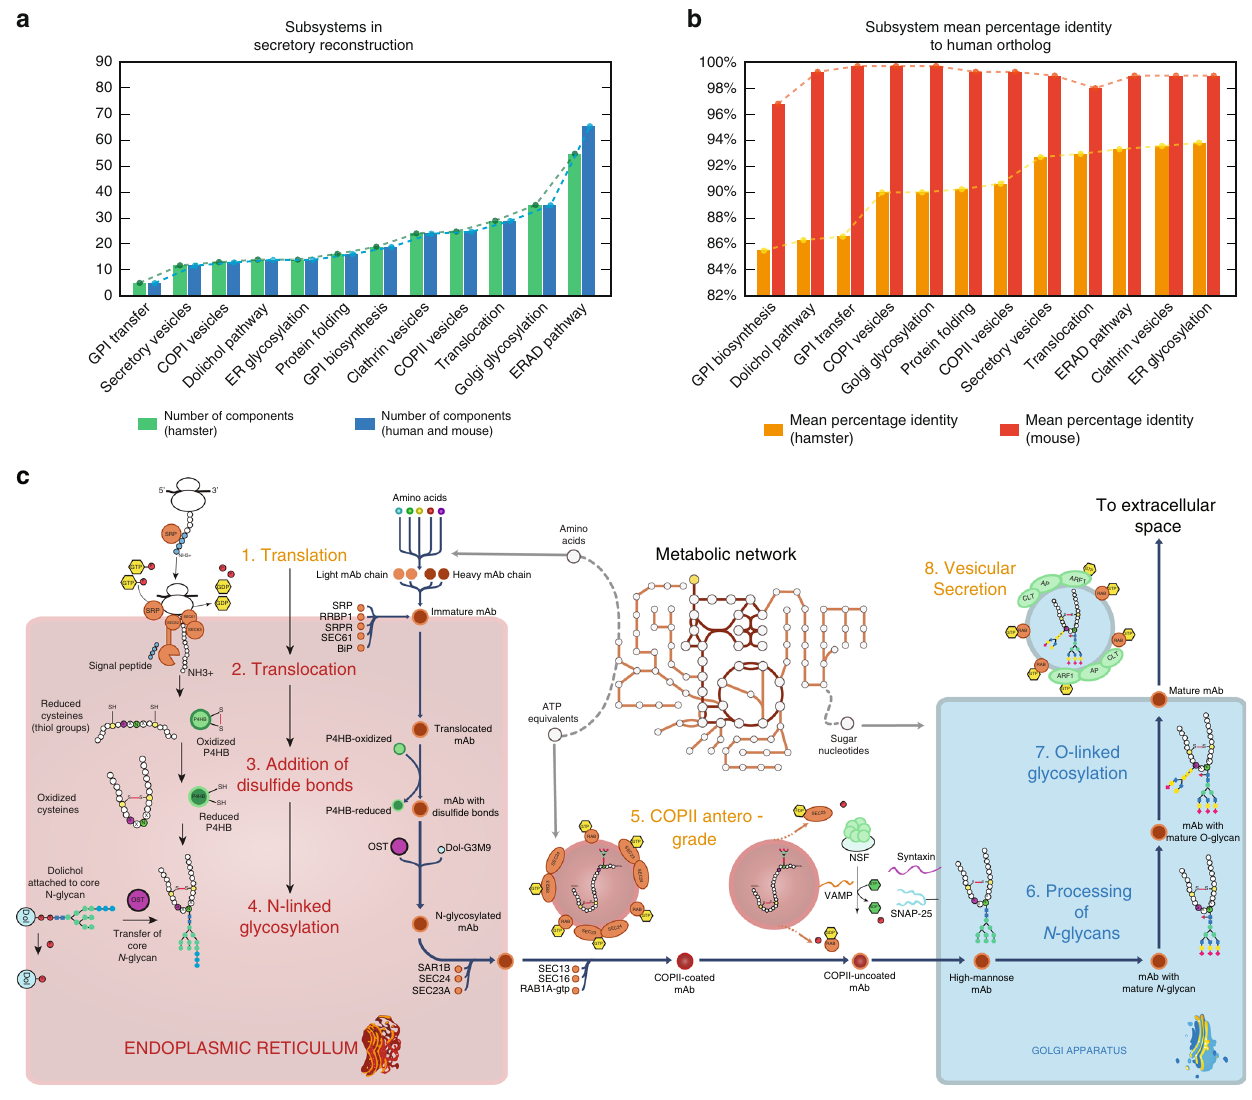
Fig. 2 Components in the reconstruction of the secretory pathway in mammalian cells. a The reconstruction comprises 261 proteins in CHO cells and 271 proteins in human and mouse that are distributed across 12 subsystems. The different component numbers arise from the fact that the Chinese hamster proteome annotation only contains one alpha and one beta proteasome subunits, whereas the human and mouse contain 12 subunits of different subtypes. b High similarities were seen for proteins in CHO and human, with a high-mean percentage identity in each subsystem (calculated with the sequence alignment tool BLAST). c Simpli fi ed schematic of reactions and subsystems involved in the secretion of a monoclonal antibody (mAb). A total of eight subsystems are necessary to translate, fold, transport, glycosylate, and secrete a mAb. The color of the subsystem names indicates if the reactions occur in the cytoplasm (orange), the ER lumen (red) or the Golgi apparatus (blue). The detailed description of all components can be found in